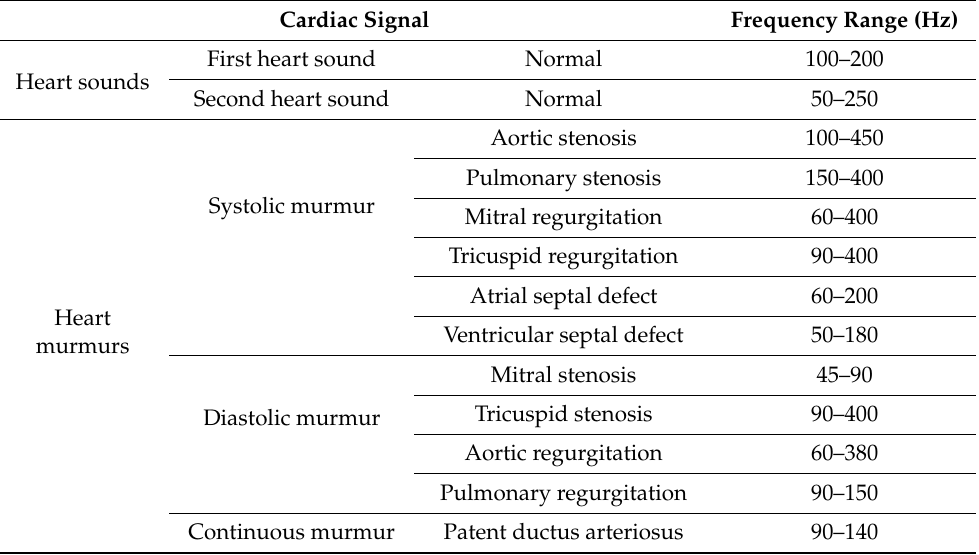
Table 1. Types of heart sounds and corresponding frequency ranges. Cardiac Signal Frequency Range